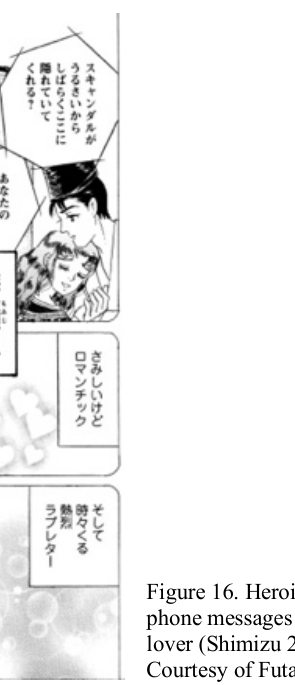
Figure 16. Heroine receives phone messages from her dream lover (Shimizu 2014, 59). Courtesy of